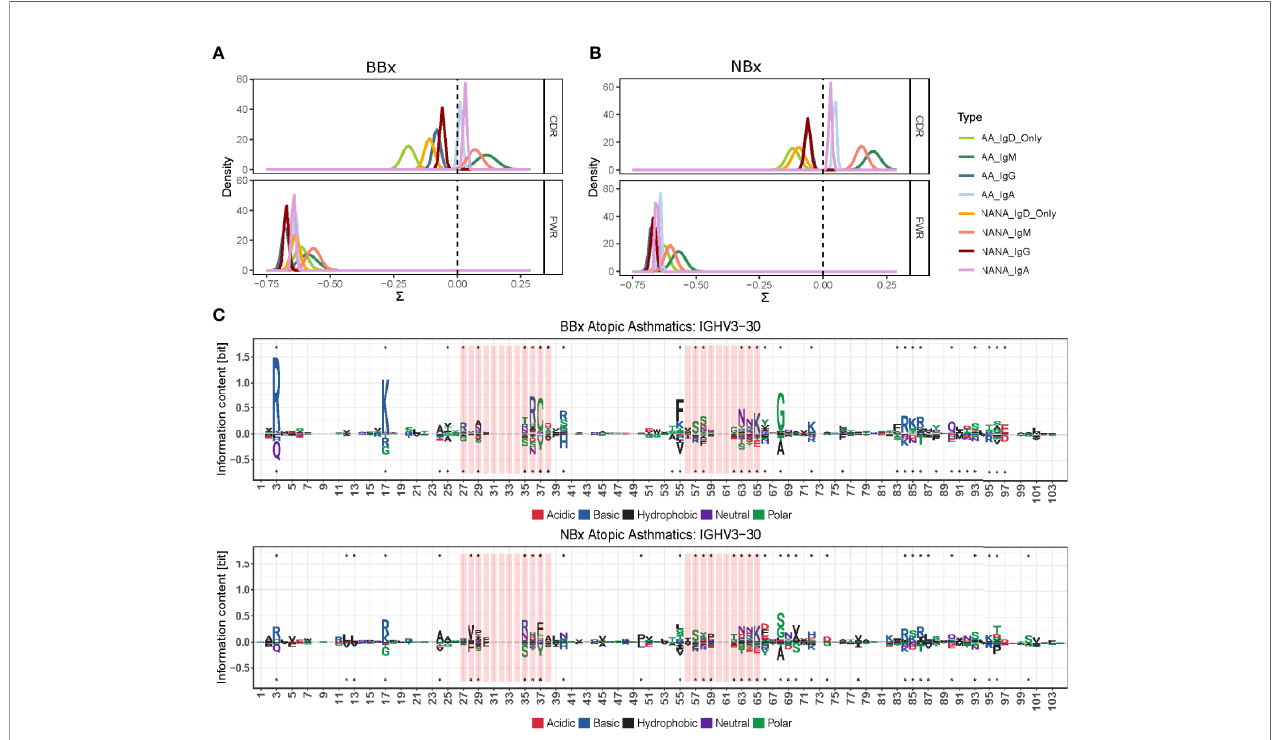
FIGURE 9 | The antigenic selection pressure exerted on IgD-only cell varies between tissues and sample types. (A, B) BASELINe estimation of the posterior distribution of selection strengths ( ∑ ) for the complementarity determining regions (CDR) and framework regions (FWR) of IgD-only sequences (light green for atopic asthmatics (AA) and yellow for non-atopic, non-asthmatic controls (NANA)] and those of other switched isotypes: IgA (light blue AA, violet NANA) and IgG (dark blue AA, maroon NANA) and IgM sequences (dark green AA, pink NANA) in (A) the bronchial mucosal and (B) the nasal mucosa samples. IgD-only sequences display signi fi cantly more negative selection strength in the CDRs compared to switched isotypes and IgM in both the bronchial and nasal mucosa. The IgD-only bronchial mucosa also showed a statistically signi fi cant difference between atopic asthmatics and non-atopic controls with asthmatics displaying the lowest pressure in the CDRs of all sample types tested. (C) Position weight matrix (pwm) analyses of somatic hypermutation generated amino acid substitutions selected for in IgD-only sequences (over the axis) and against (below the axis) in the IGHV3-30 gene in the bronchial (top panel) and nasal (bottom panel) mucosa of atopic asthmatics. The red areas indicate CDR1 and 2 and the white areas are the FWRs. The letters denote the one letter amino acid codes and the colors show the properties of the amino acids selected for or against with red = acidic, blue = basic, black = hydrophobic, purple = neutral and green = polar. The size of the letters shows the strength of selective pressure in the given position. Dots indicate signi fi cant differences between IgD-only and the other